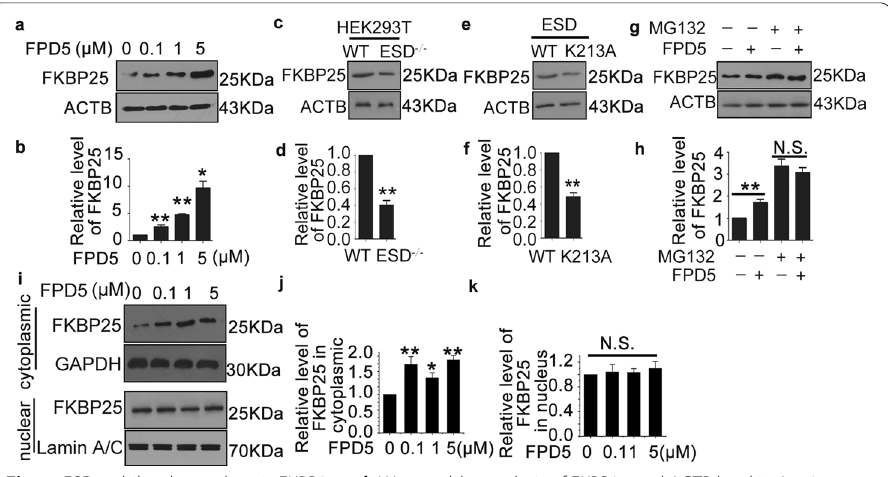
Fig. 4 ESD stabilized cytoplasmic FKBP25. a , b Western blot analysis of FKBP25 and ACTB level in A549 cells treated with FPD5 at 0–5 μM for 24 h. c , d Western blot analysis of FKBP25 level in HEK293T-WT and HEK293T-ESD − / − . e , f HEK293T cell line was transfected with plasmids pCAG-ESD-WT and pCAG-ESD-K213A for 48 h. Then the level of FKBP25 was analyzed by western blot. g , h Western blot analysis of FKBP25